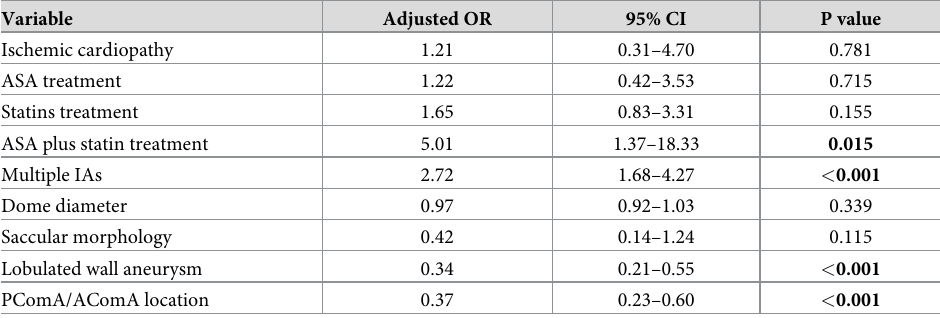
Table 2. Multivariate regression model for unruptured intracranial aneurysm at diagnosis. Variable Adjusted OR 95% CI P value Ischemic cardiopathy